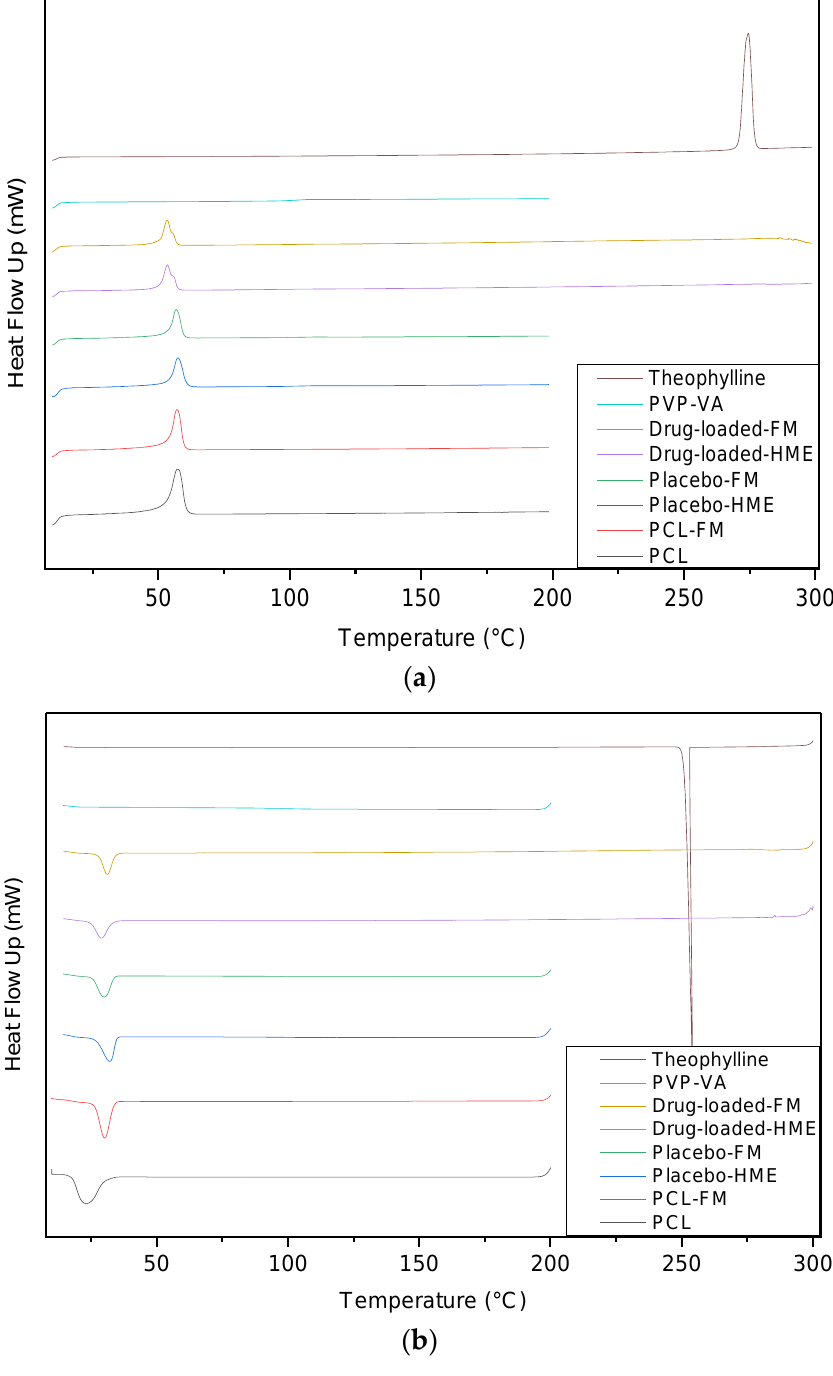
Figure 8. Overlaid DSC thermograms of all of the material: ( a ) heating; ( b ) cooling. Table 4. The calculated temperature transitions of the samples from the DSC thermographs.